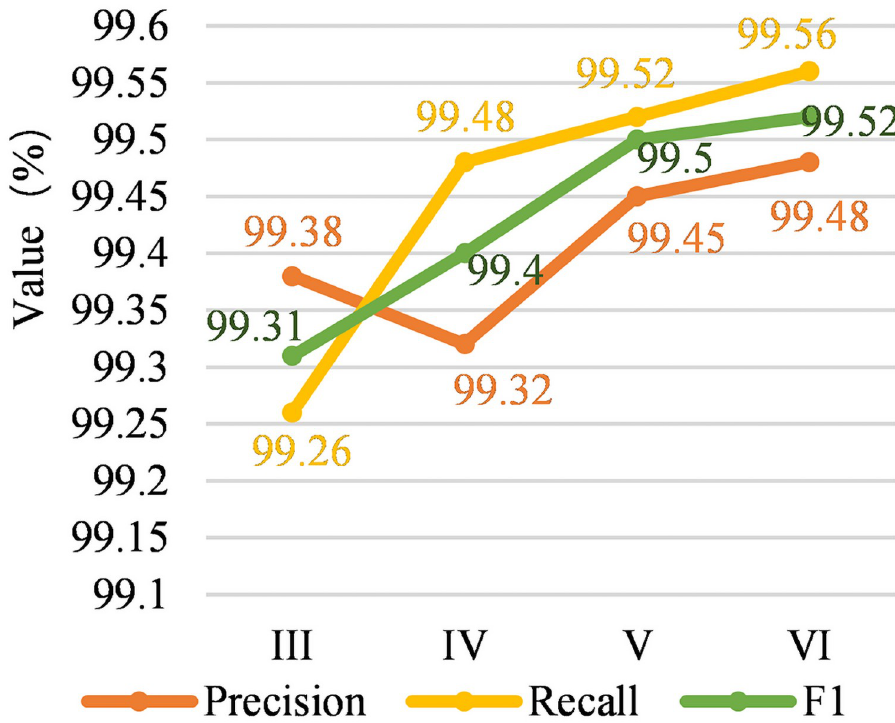
Fig 7. Comparison on precision, recall, F1 results of different